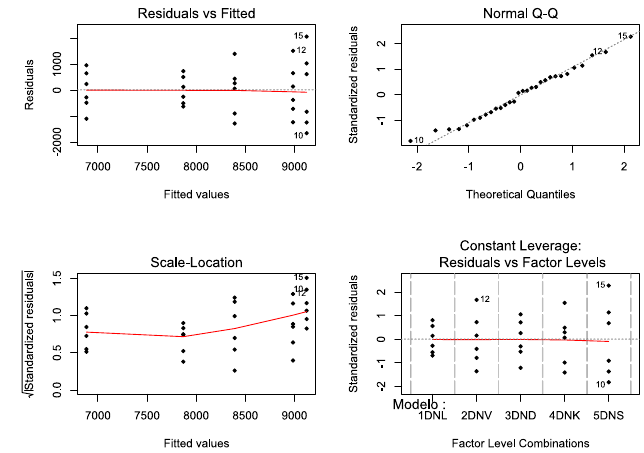
Figure 5. Graphical analysis of residuals of the ANOVA contrast of the model vs. scrap.